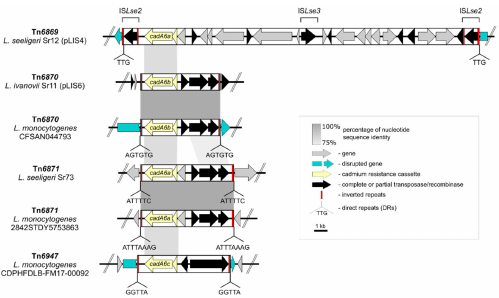
Figure 4. Comparative analysis of transposons Tn 6869 ( L. seeligeri Sr12), Tn 6870 ( L. ivanovii Sr11), Tn 6871 ( L. seeligeri Sr73), and Tn 6947 ( L. monocytogenes CDPHFDLB-FM17-00092), harboring the cadA6 cadmium resistance cassette. Sequences were aligned and visualized using EasyFig. Tn 6870 present in L. monocytogenes CFSAN044793 (GenBank acc. no. NZ_NYDG01000002) and Tn 6871 from L. monocytogenes 2842STDY5753863 (NZ_FFER01000001.1) were included in the analysis. Gray shading indicates DNA regions with at least 75% nucleotide sequence identity of at least 100 bp in length. The sequences of direct repeats flanking the transposons are shown beneath each diagram. The inverted repeat sequences are not identical (no. of identical base pairs / total length of IR): Tn 6869 (22 / 30), Tn 6870 (39 / 48), Tn 6871 (41 / 47), Tn 6947 (35 /